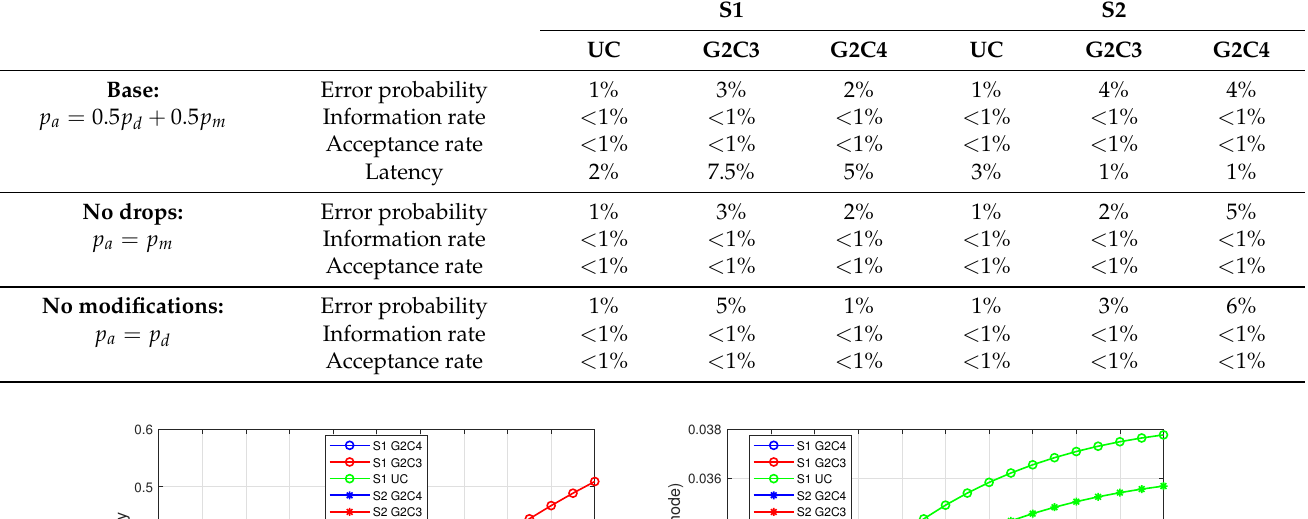
Table 5. Maximum relative error between the analytical model and simulation.